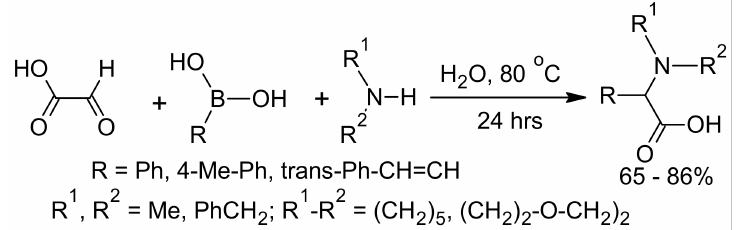
Scheme 23. Petasis amino acid synthesis in